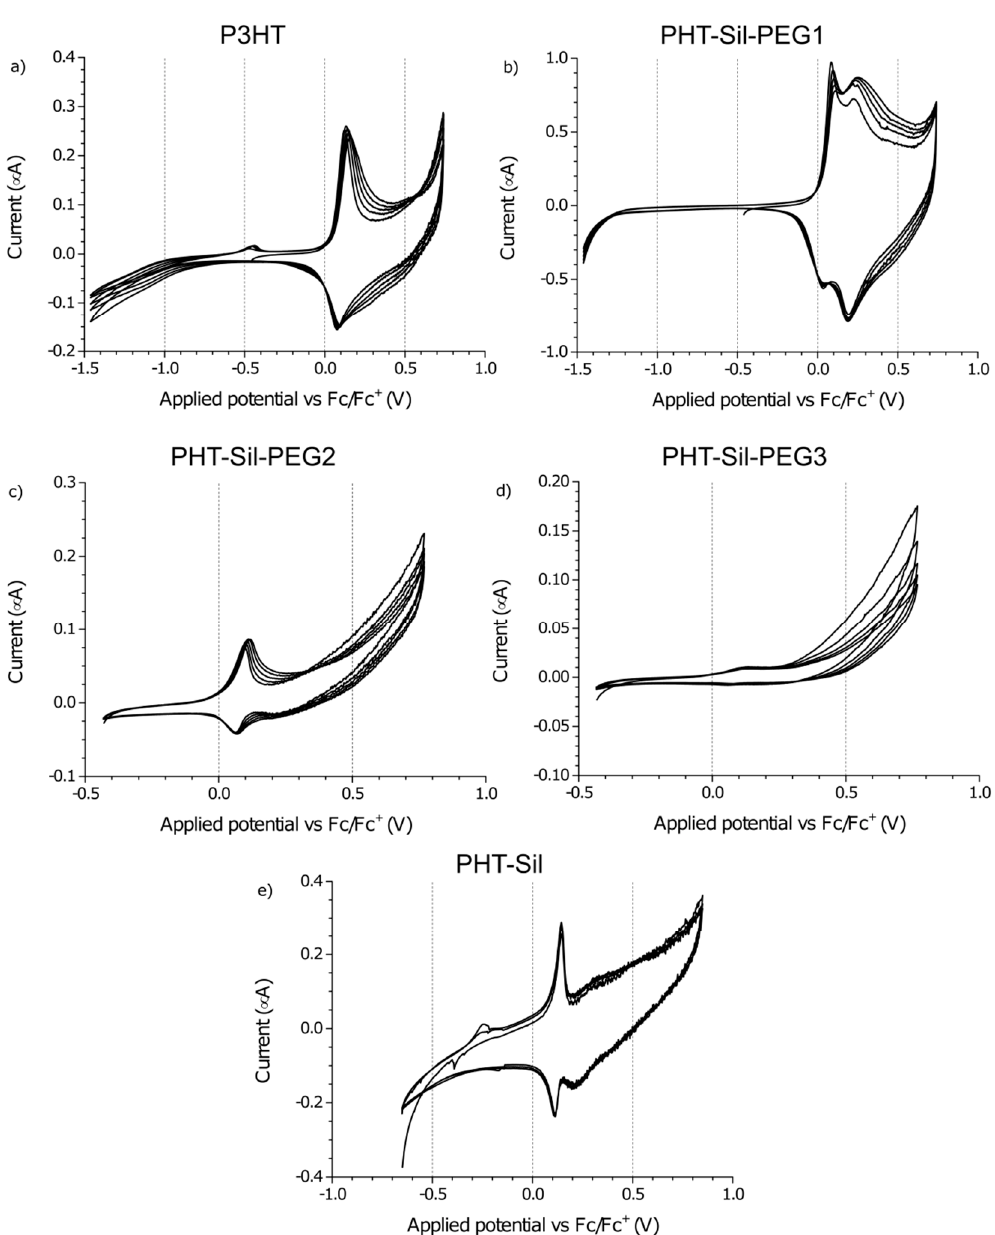
Figure 5. Electrochemical response of thin solid films of ( a ) regioregular P3HT; ( b )